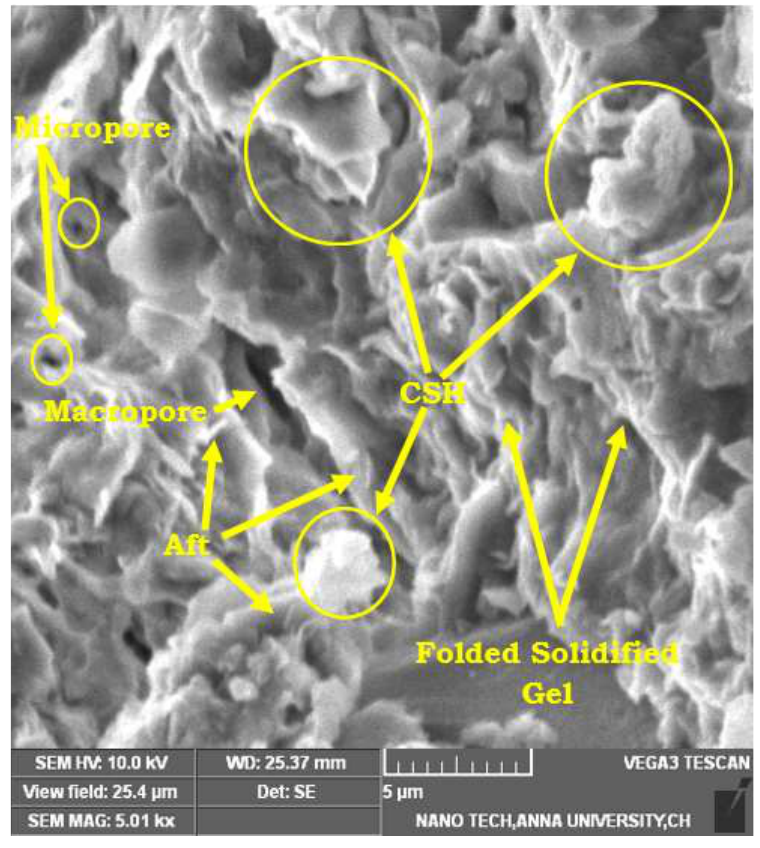
Figure 7. SEM Micrograph of LP3.